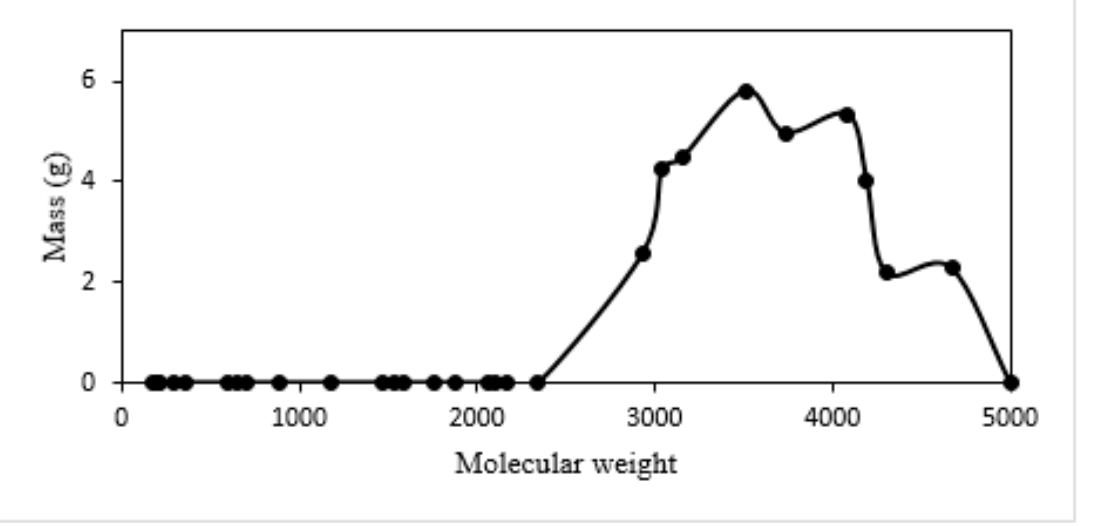
Figure 16. Calculated molecular weight distribution of the residue of a 50 g mass coal tar pitch during coke formation step (where the temperature is about 550 °C) of carbonization process with heating rate of 50 °C/h.